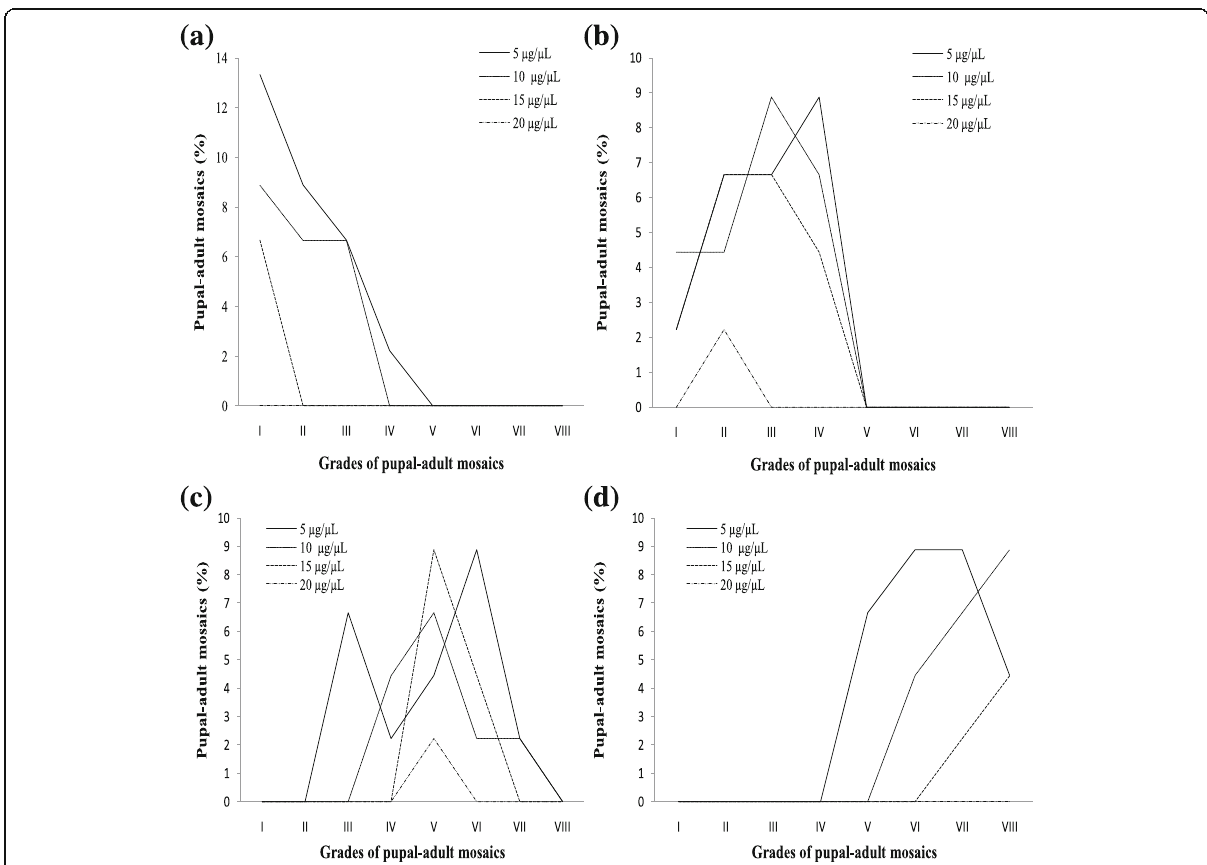
Fig. 3 Different grades of pupal-adult mosaics produced by the treatment of a 0-day-old third instar larvae, b 1-day-old third instar larvae, c 2- day-old third instar larvae, and d 3-day-old third instar larvae of S. ruficornis with root extracts of W.